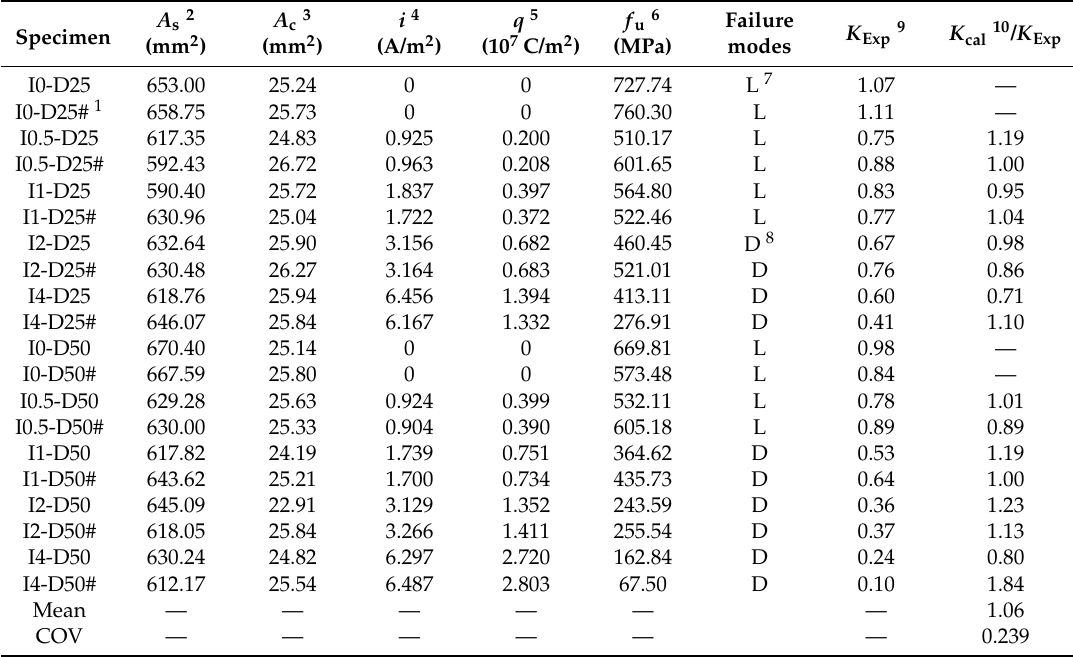
Table 2. Parameters and test results used for tensile tests after